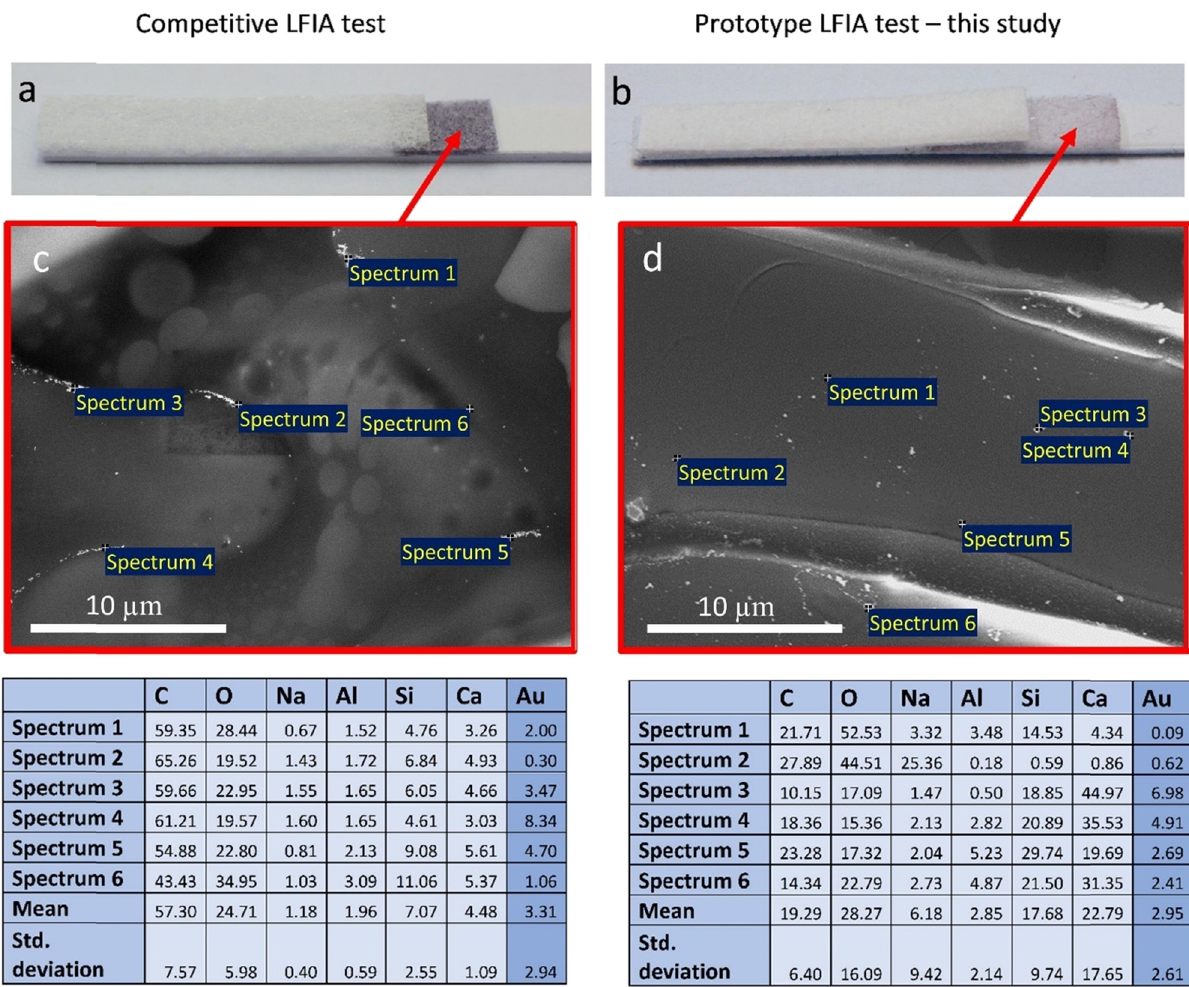
Figure 8: Comparison: macro - view: ( a ) commercially available LFIA test and ( b ) prototype LFIA test - this study; SEM micrograph with corresponding EDS spectra on selected sites: ( c ) conjugate pad of the commercially available LFIA test and ( d ) conjugate pad of the prototype LFIA test - this study.